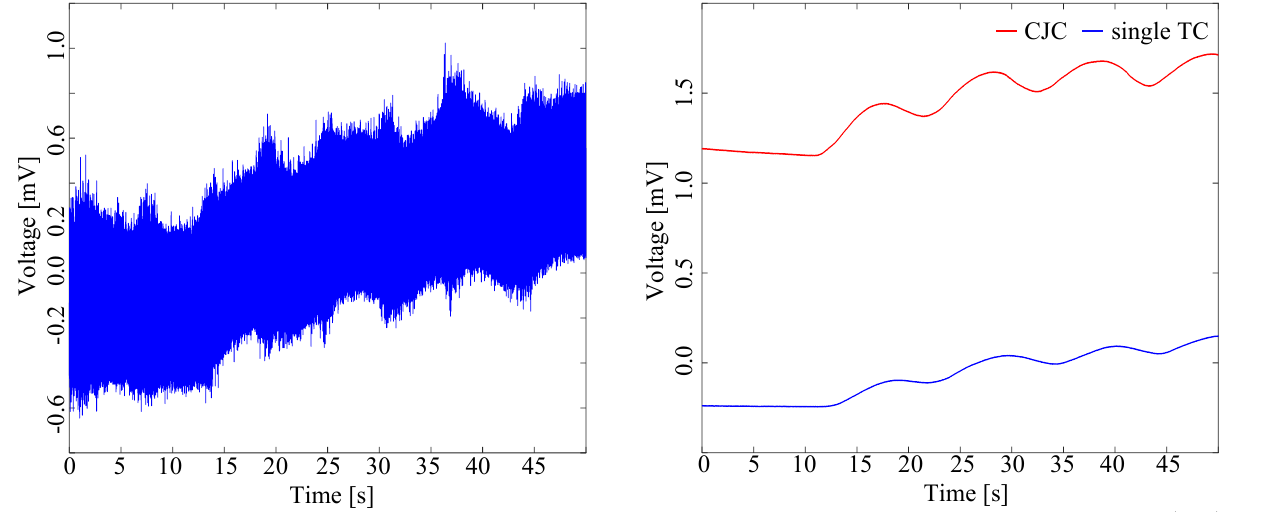
Fig. 3. Signal acquired by NI 9234 with the thermocouple directly touching the copper pipe